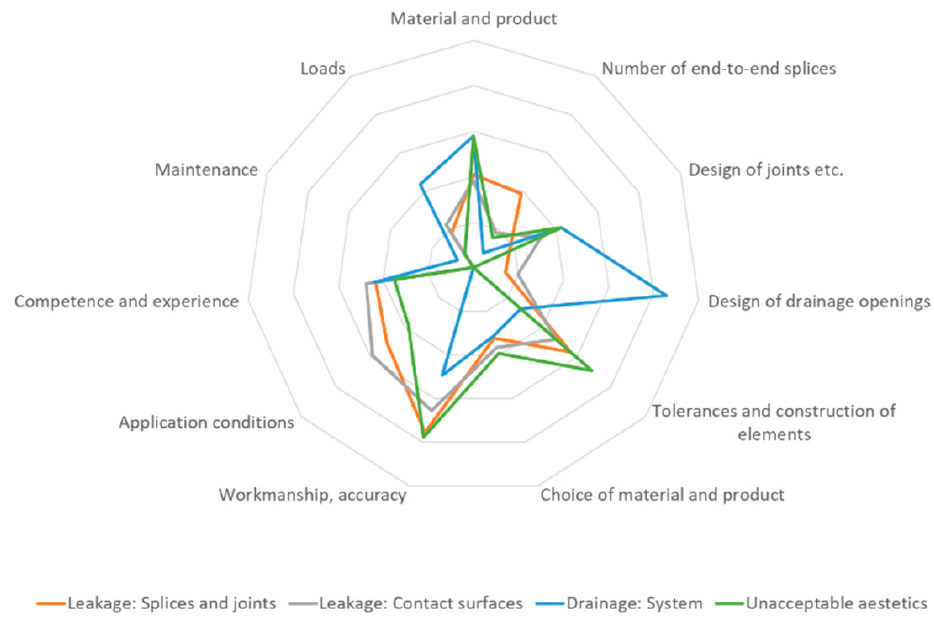
Figure 4. Assessment of the importance of influencing factors for the four selected risk clusters.